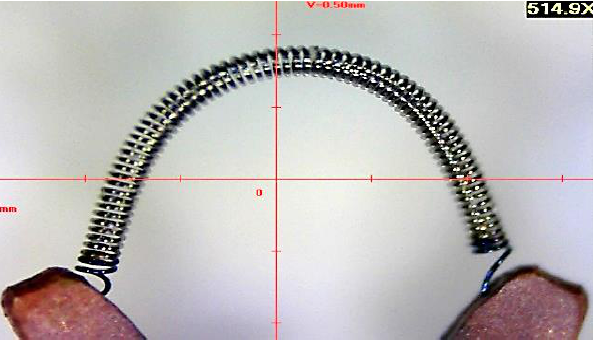
Figure 6. Microscopic picture of IR light source.